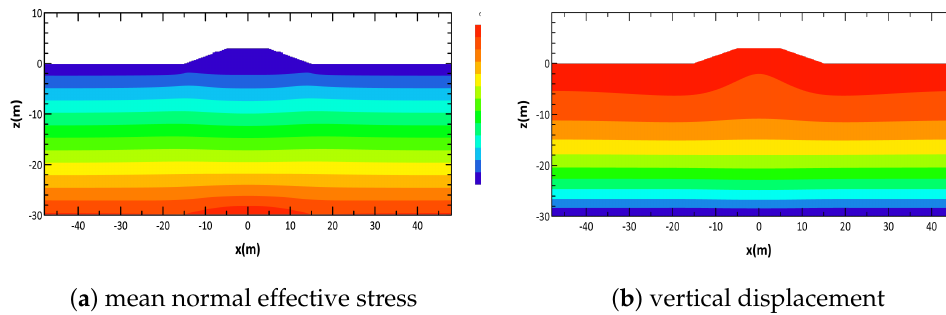
Figure 4. Distributions of the mean normal effective stress and vertical displacement in a porous seabed after